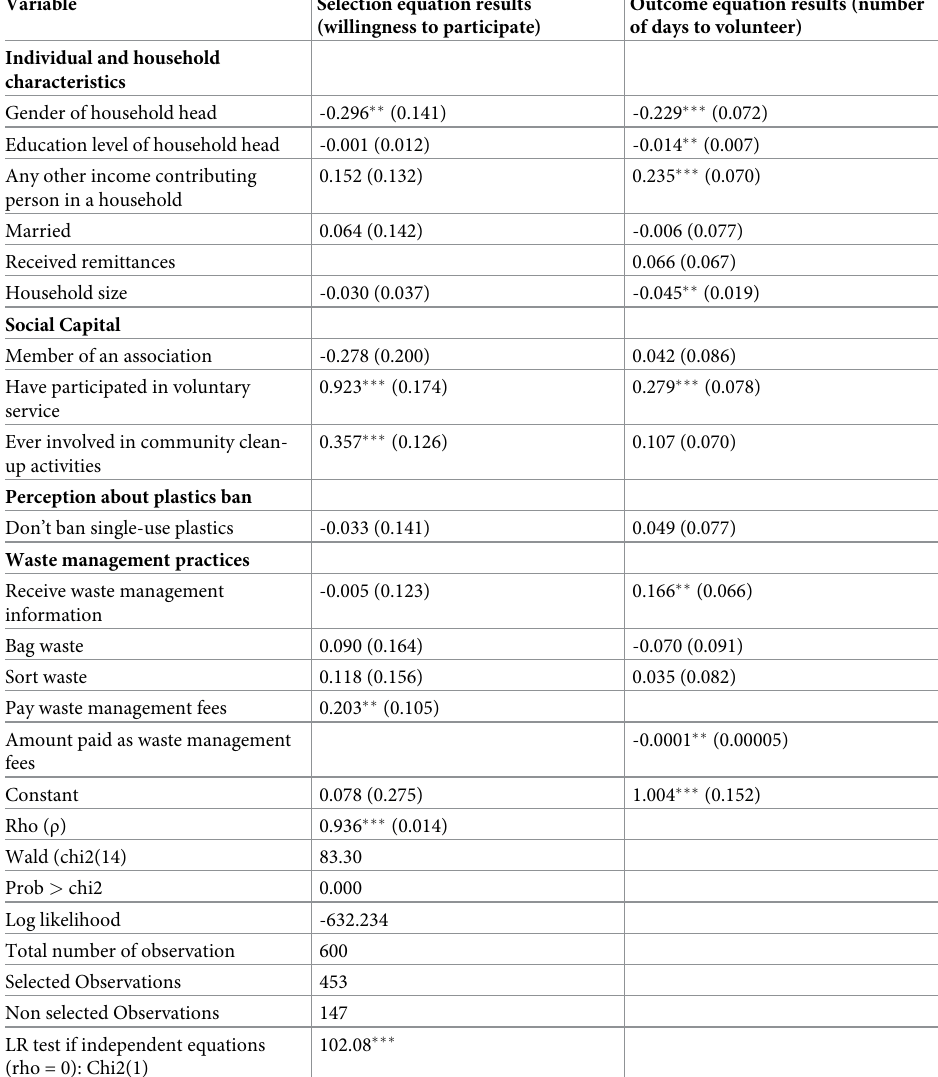
Table 4. Result of Heckman selection model showing the determinants of the willingness of the respondents to participate in the cleanup drainage channels and number of man-days they are willing to contribute. Variable Selection equation results Outcome equation results (number (willingness to participate) of days to